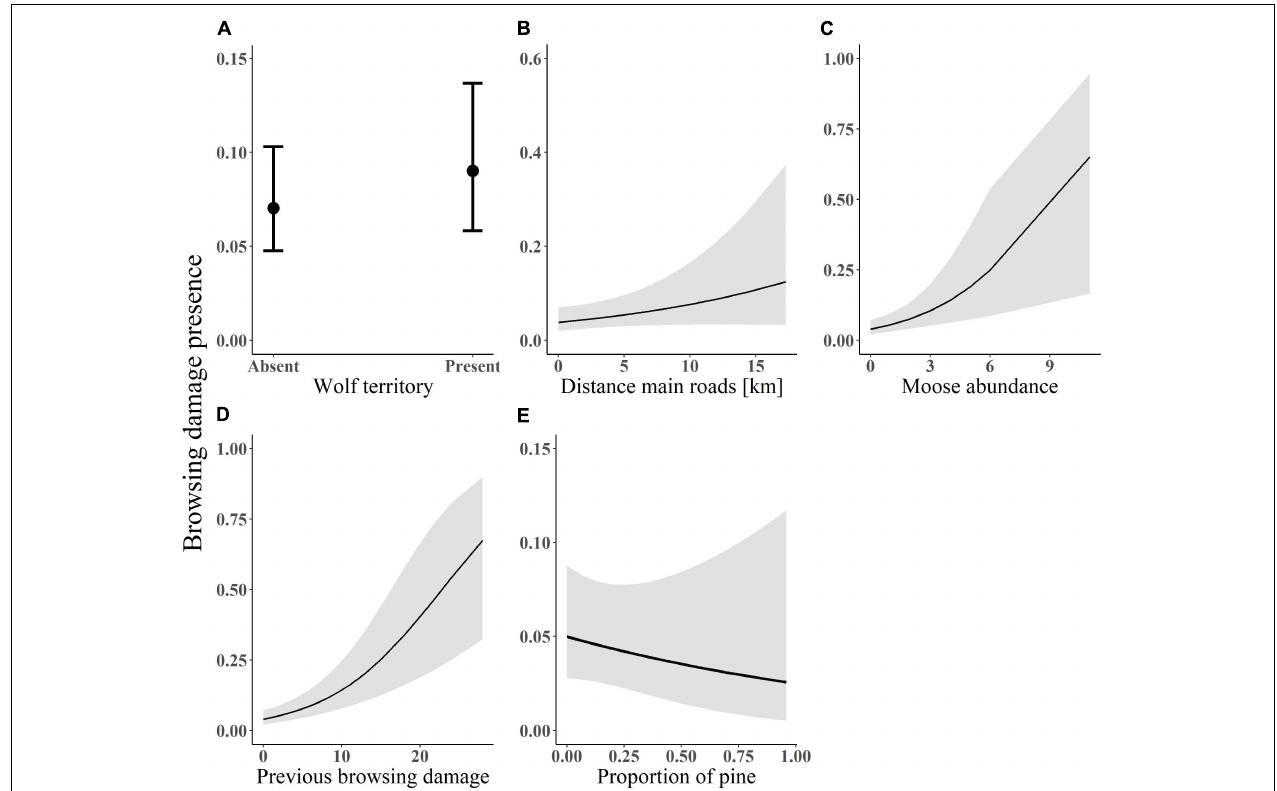
FIGURE 3 | Predicted probability of browsing damage presence on pine in relation to (A) wolf presence; (B) distance from main roads; (C) moose abundance; (D) previous browsing damage; and (E) pine proportion. Data on browsing was collected within south-central Sweden between 2003 and 2016. The lines (in plot B–D ) indicates the fitted values with associated standard errors from the model-averaged estimates. Plot a shows the coefficients and confidence intervals of the predicted probability of browsing damage presence in relation to presence/absence of a wolf